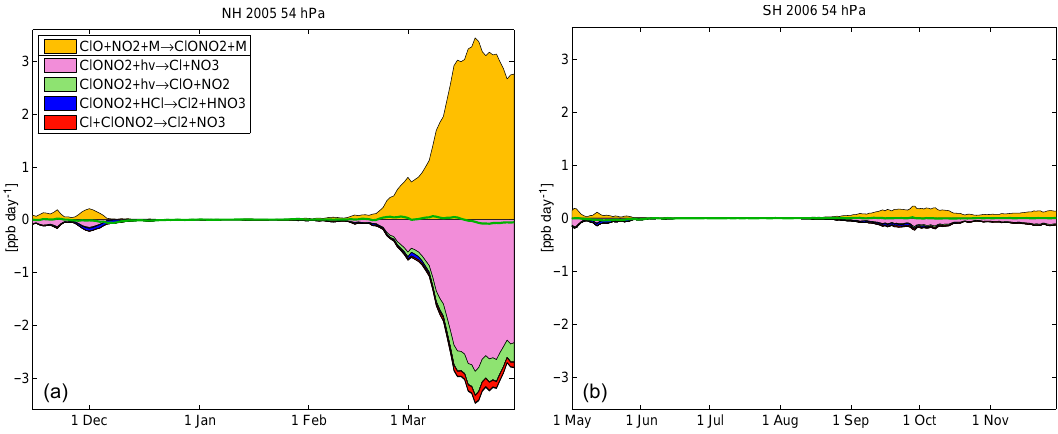
Figure 16. Vortex-averaged chemical reaction rates involving ClONO 2 for the Arctic winter 2004–2005 and the Antarctic winter 2006 at 54hPa. Production reactions are shown as positive and are separated by a line in the legend from the loss reactions, which are shown as negative. The net change of ClONO 2 is shown as a green line. Reactions with rates which cannot be distinguished from the zero line at plot resolution are not shown.